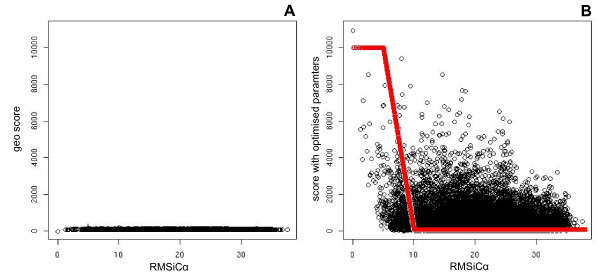
Comparison of the distribution of calculated geometric correlations for a protease/inhibitor example (2SIC) (A) without and (B) with optimised parameter. The red line in B is the objective function used for the optimisation procedure. Each black circle represents one potential complex structure.